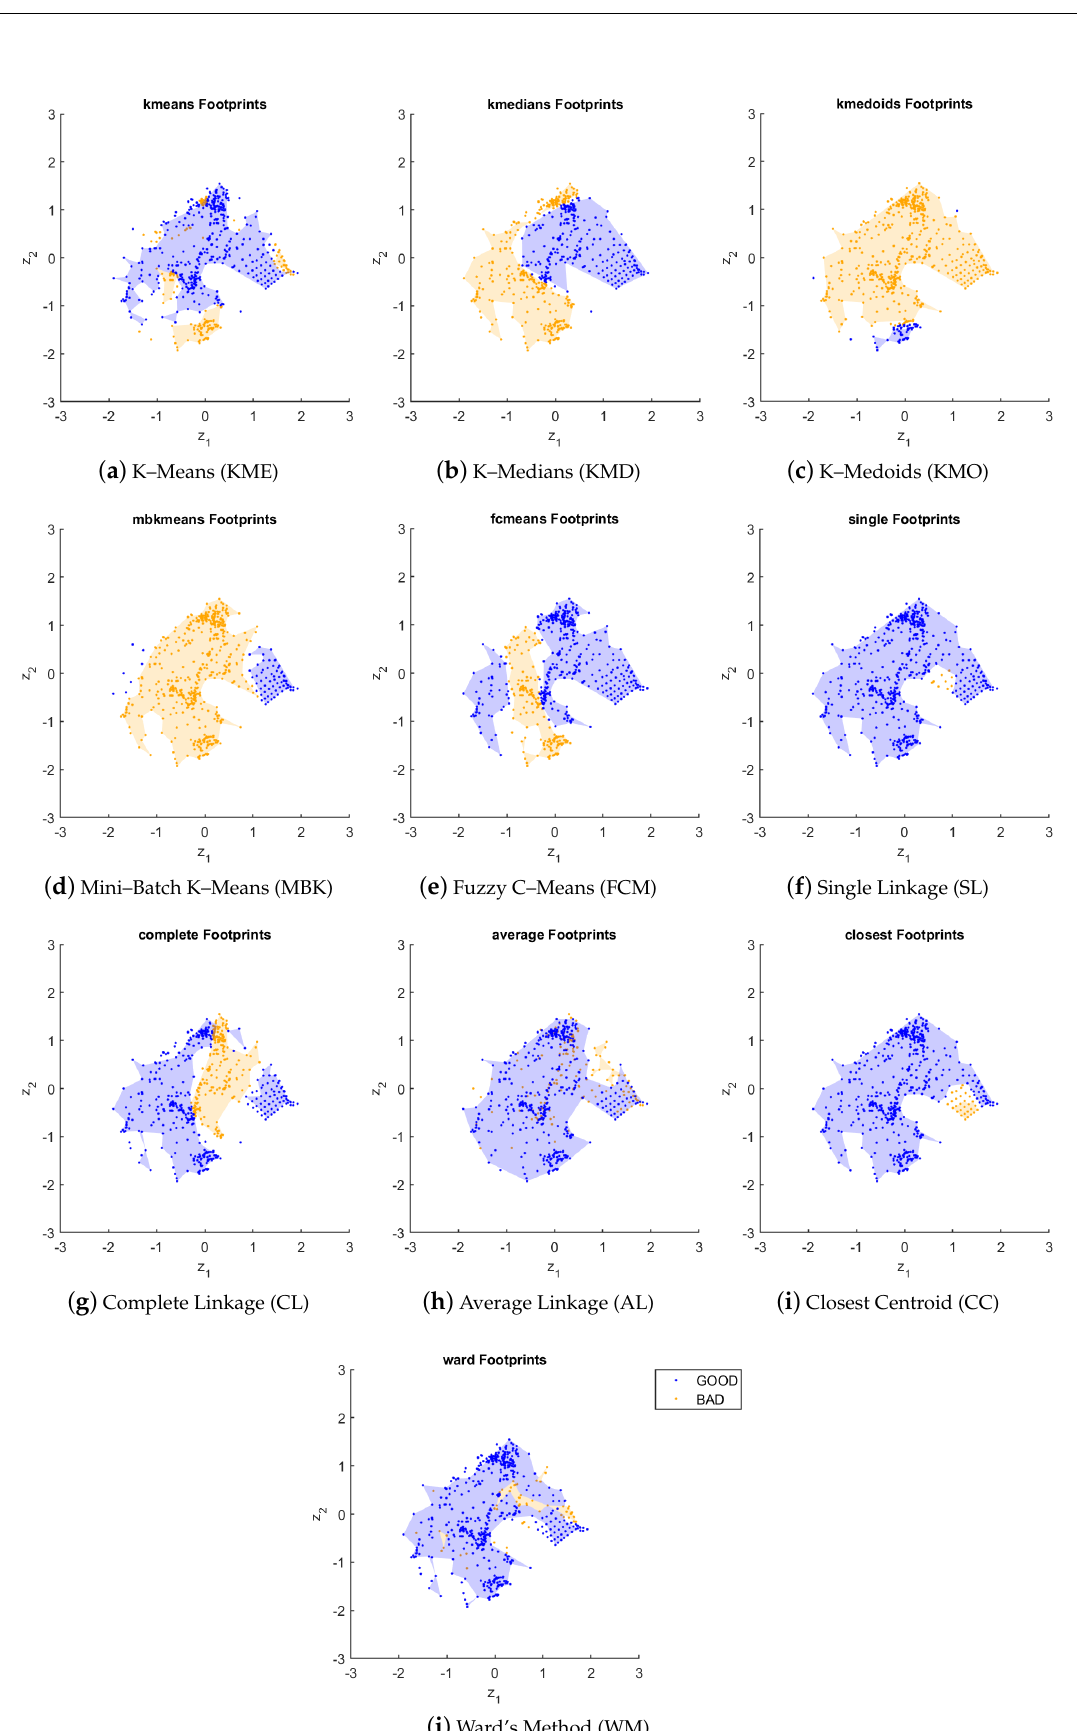
Figure 10. Footprints of the algorithms in the instance space after the inclusion of real